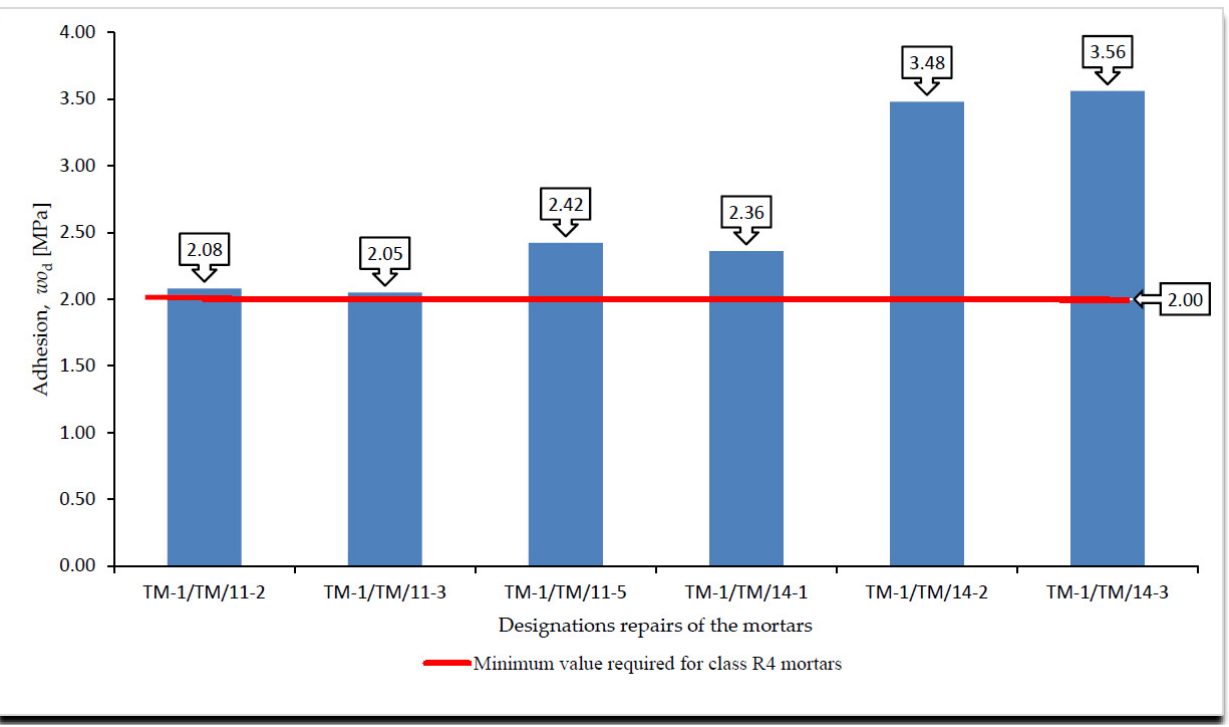
Figure 5. Summary of the average values of temporary adhesion by pull-off method of R4 class mortars to concrete substrate, wo d [MPa].